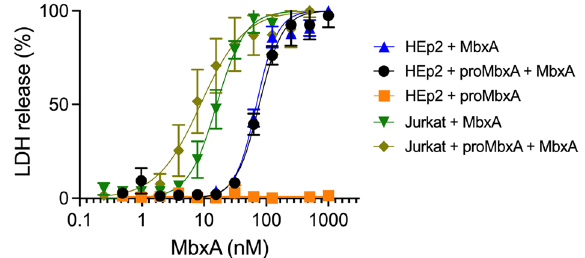
Figure 8. proMbxA does not protect epithelial cells (HEp-2) from MbxA-induced membrane damage. Preincubation with 250 nM of proMbxA for 30 min at 37 °C resulted in a nearly identical dose–response curve to MbxA (black) compared to treatment with MbxA alone (37 °C for 30 min, blue). proMbxA was not cytotoxic (orange). A similar effect was observed for Jurkat cells. Preincubation with 250 nM of proMbxA for 30 min at 37 °C resulted in a not significant different dose–response curve to MbxA (light green) compared to treatment with MbxA alone (37 °C for 30 min, green). The cytotoxicity mediated by MbxA-induced membrane damage was measured using an LDH release assay. LDH release into the supernatant was measured after 1 h of incubation with MbxA. The relative LDH release was calculated from the maximal LDH release reached in each measurement, which was set to 100%. For the CD 50 determination the MbxA cytotoxicity was plotted against the MbxA concentration and fitted with GraphPad Prism 7 according to Eq. (2) (see material and